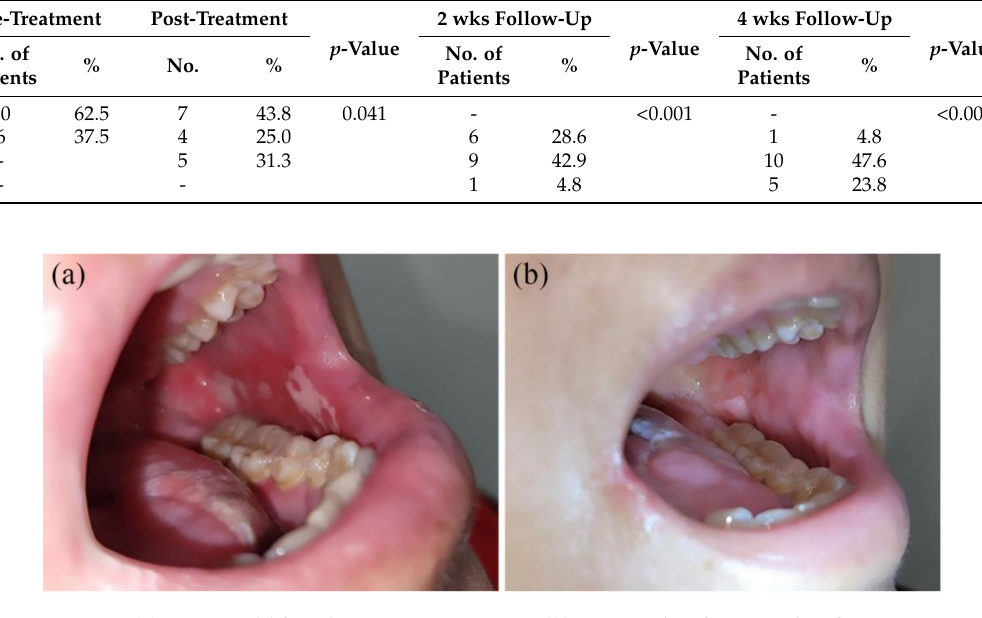
Figure 3. ( a ) 50-year-old female prior to treatments. ( b ) At 2 weeks after 4 weeks of PBMT